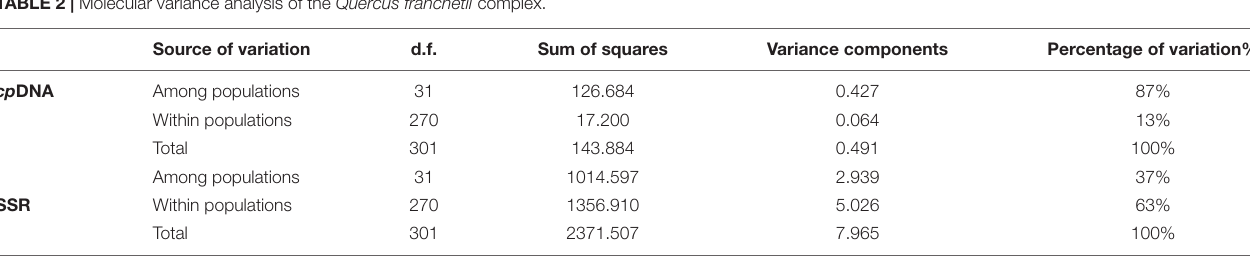
TABLE 2 | Molecular variance analysis of the Quercus franchetii